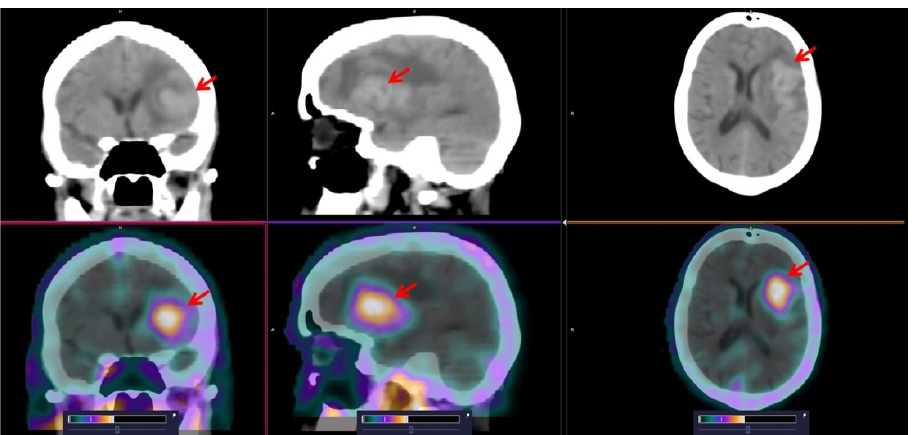
Figure 4. SPECT/CT images of patient 12 at 2 h after injection of [ 99m Tc]Tc-TG. High [ 99m Tc]Tc-TG uptake in left frontoparietal region of the brain (SUVmax = 2.65) is visualized (arrows). The upper setting of the scale window (65% of the maximum number) was adjusted to visualize the lesion.